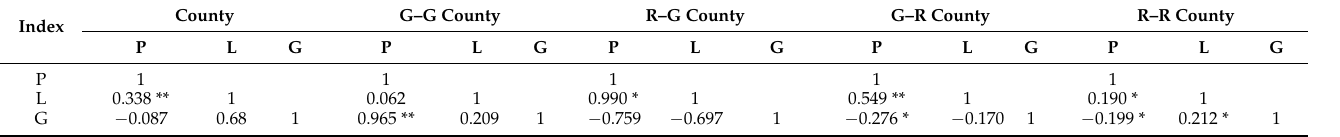
Table 4. Correlation analysis between resident population, construction land area, and GDP changes from 2000 to